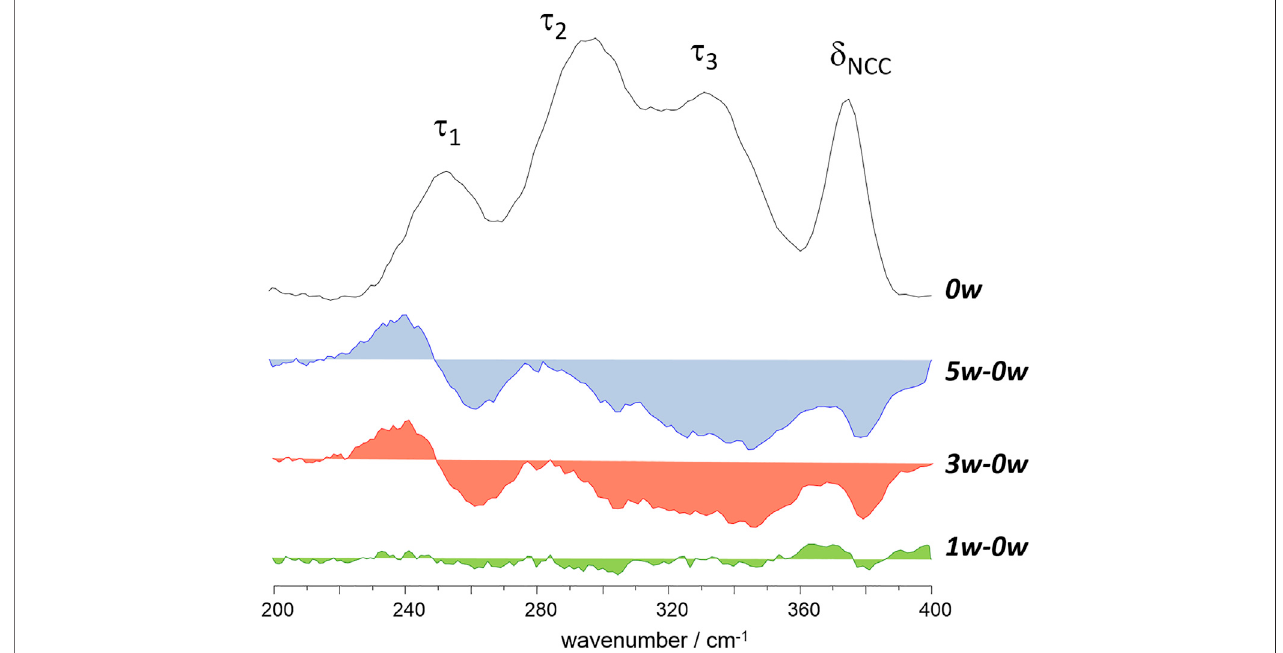
FIGURE 4 | A close-up of the region of methyl torsions in the ChCl:urea mixture: the difference spectra ( wet minus dry ) for the DES:water molar ratios of 1:1 (1w- 0w), 1:3 (3w-0w), and 1:5 (5w-0w), compared with the spectrum of the dry sample (0w).